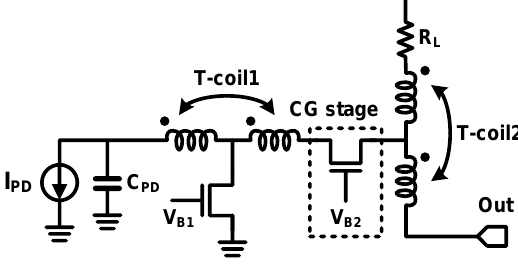
Figure 34. CG TIA with T-coil peaking presented in [82].